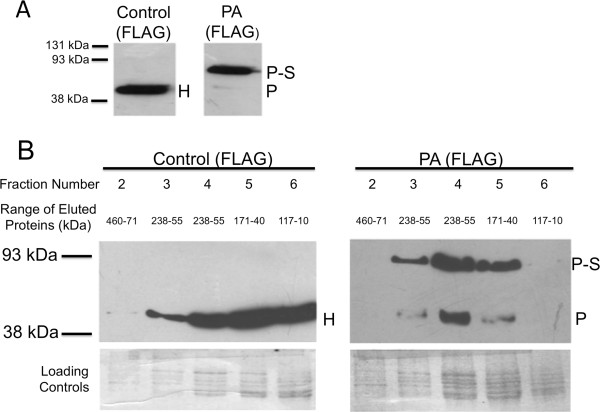
High-level expression of the PA incompatibility domain results in an interaction with Hsp70 protein concomitant with remediation of aberrant PA-associated phenotypes. A) Proteins were extracted under reducing conditions from PA-expressing and control yeast grown in YPRaf/Gal. Immunoblotting using anti-FLAG antibody reveals that over-expressed PA(FLAG)p forms a complex (P-S) with another protein that was identified by mass spectroscopy as Ssa1p (Additional file 1: Table S1). The weak PA(FLAG)p signal (P) demonstrated that most PA(FLAG)p is sequestered into this PA(FLAG)p-Ssa1p complex. The position of control (FLAG) protein is indicated (H). B) When overexpressed, virtually all of the PA(FLAG)p interacts with Ssa1p. Cells were grown overnight at 30°C in YPD, washed in PBS, resuspended in YPRaf/Gal and grown with shaking until mid-log phase. Proteins were then extracted and subjected to size exclusion chromatography as described in the main text. The control (FLAG) protein was detected in fractions 3–8. In contrast, the PAp monomer was detected only in the presence of the Ssa1p-PA(FLAG)p complex (fractions 3–5). This indicates that the majority of PA(FLAG)p was bound to Ssa1p and that treatment with reducing agents prior to immunoblotting dissociated some but not all of the PA(FLAG)p from the complex. Duplicate Coomassie blue stained protein gels were used to verify equal loading across lanes. Positions of molecular weight markers are shown at left. For both panels, similar trends were observed in two independent extractions and immunoblots.